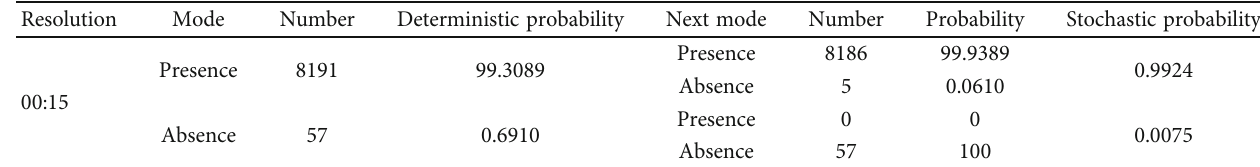
Figure 12: A process model for extracting and monitoring data from a time-use survey. Table 7: A step from the Markov chain regardless of the family dimension.